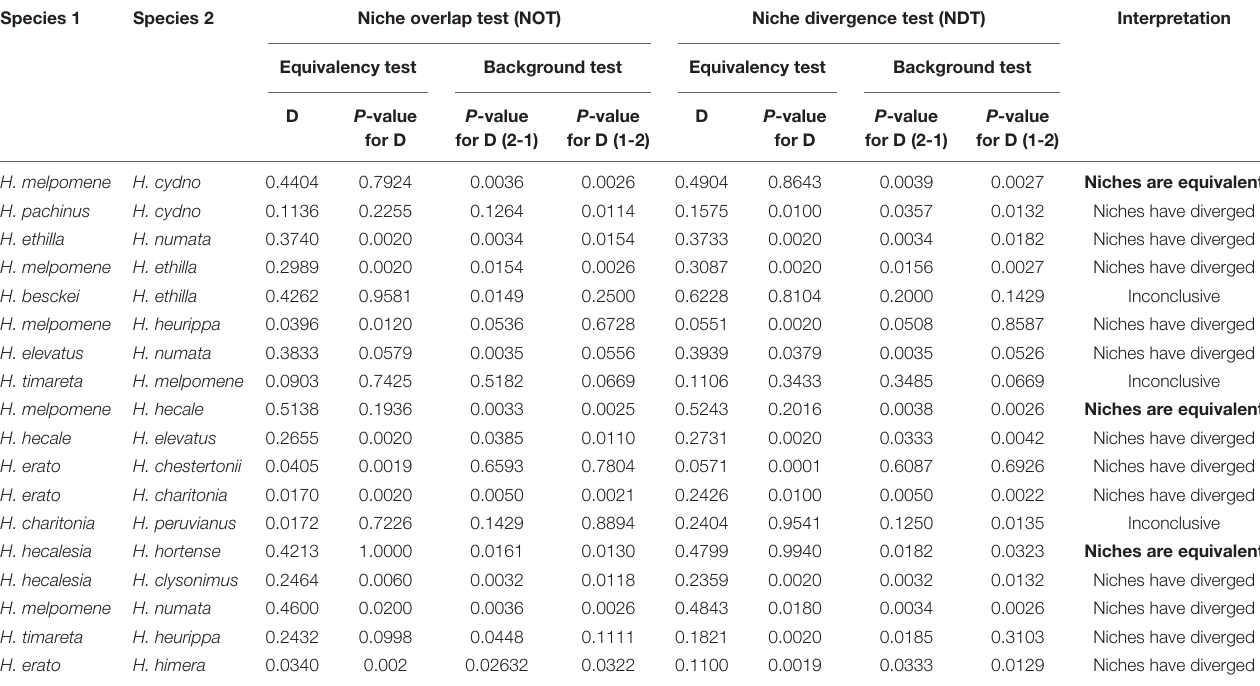
Bolded text means that the occupied niches by these two species are not statistically different.